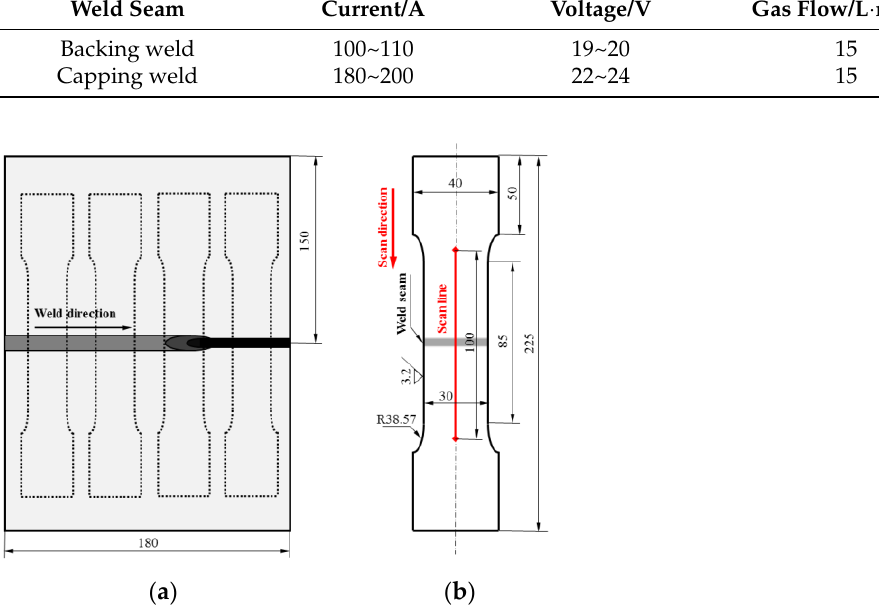
Figure 1. Sketch of specimen preparation. ( a ) Welding direction and sampling location, and ( b ) ge- ometry and dimensions of the fatigue specimen. All dimensions are in mm. and dimensions of the fatigue specimen. All dimensions are in